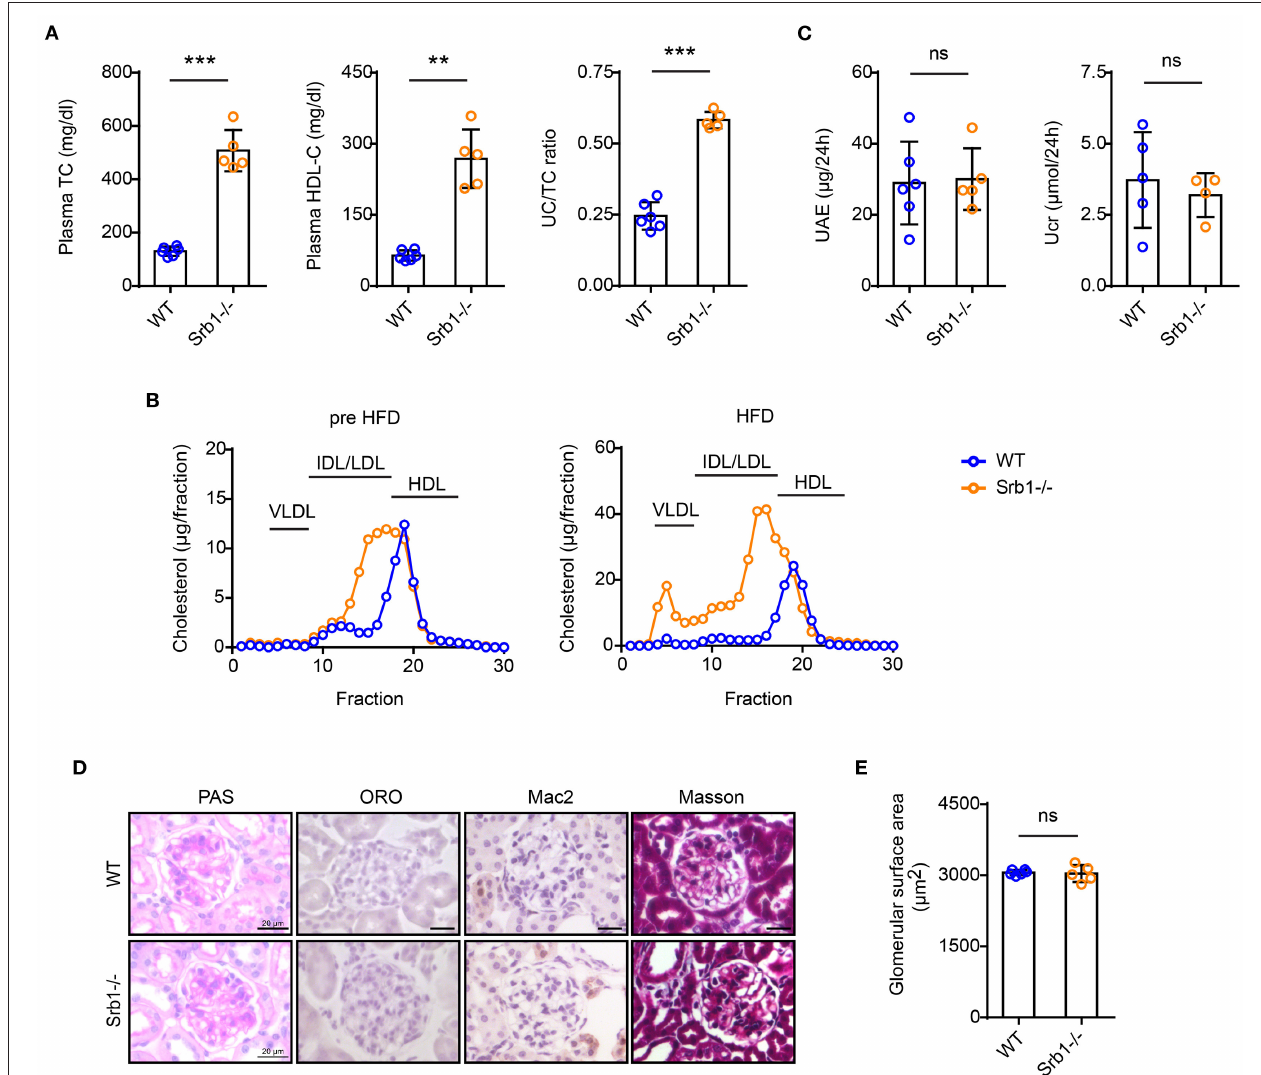
FIGURE 2 | Plasma lipid parameters and renal function/histology in Srb1-/- and wild-type mice fed on HFD diet. (A) Plasma TC levels, HDL-C levels, and UC/TC ratios; (B) Lipoprotein profiles fraction by FPLC; (C) 24-h UAE and Ucr; (D) Representative glomeruli stained with PAS, ORO, Mac2, and Masson; (E) Glomerular surface area; (E) Quantitation of ORO-positive lipoprotein deposition. n = 5–6 per group. ** : p < 0.01; *** : p < 0.001; ns: no